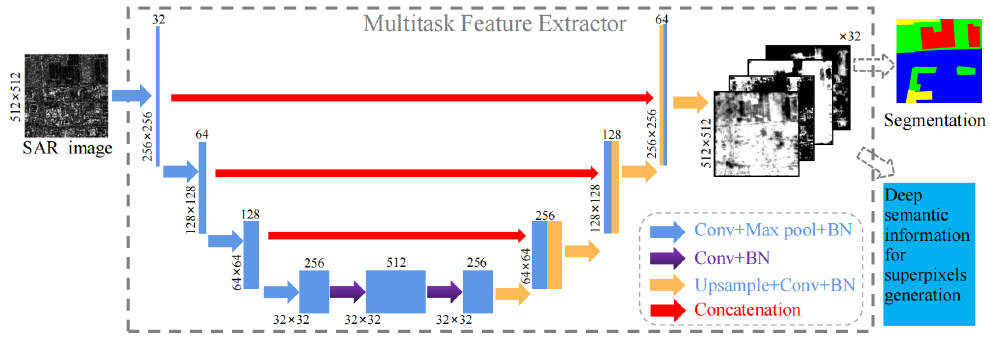
Figure 2. The network structure of multitask feature extractor.